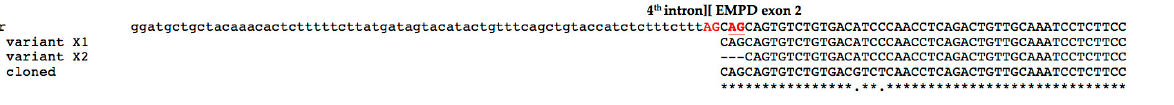
Figure 5. Alignment of the T. bernacchii pIgR genomic sequence with that of the three transcript variants. Of the pIgR genomic sequence (gT.ber), retrieved from the T. bernacchii genome, only the region spanning the 3 ′ end of the fourth intron and the 5 ′ end of the EMPD exon 2 is shown. Two pIgR variants (T.ber variant X1 and T.ber variant X2) are predicted from the genome; the pIgR cDNA variant (T.ber cloned) has been isolated in the present study. The canonical acceptor splicing site is depicted in red. The cryptic splicing site is in bold red and underlined. Gaps are indicated by dashes. Identical nucleotides are indicated with an asterisk below the alignment; positions differing in one nucleotide are marked by dots.